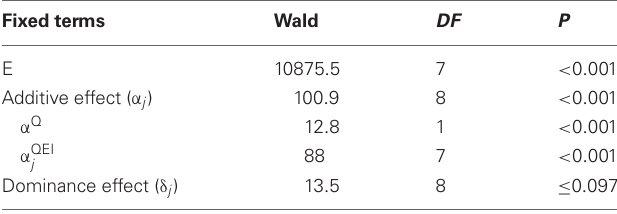
Table 6 | Results of the test for fixed effects in a mixed model including a fixed environment–specific additive ( α j ) and dominance ( δ j ) QTL